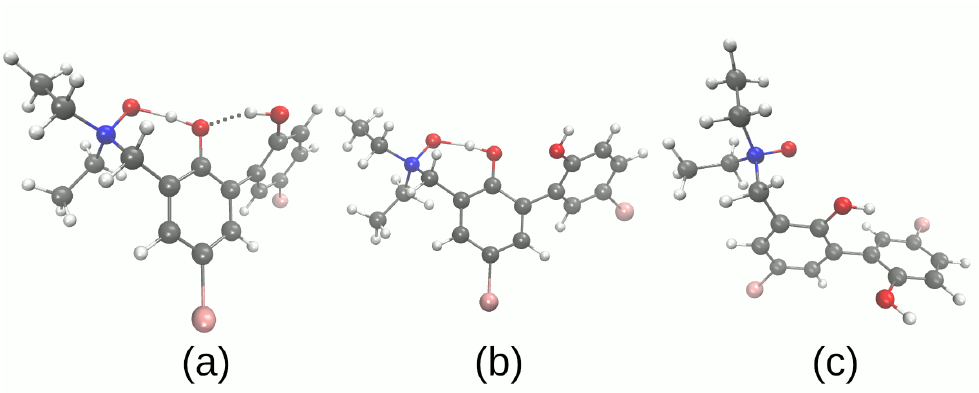
Figure 3. Conformers of the compound 2 computed at the B3LYP/6-311++G(d,p) level of theory. ( a ) closed form; ( b ) with one hydrogen bond; ( c ) open form.